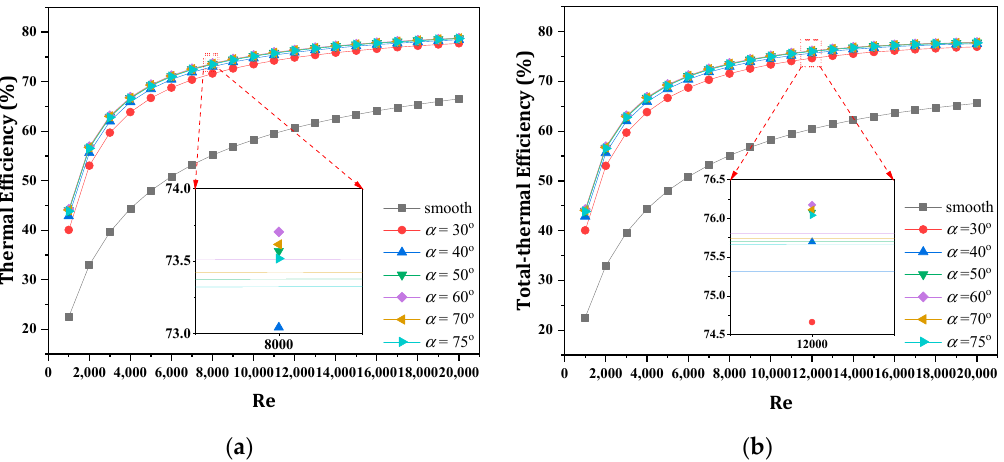
Figure 10. Re at various angles of attack (in the range of 30 – 75° ) versus the ( a ) thermal efficiency and ( b ) total thermal efficiency.